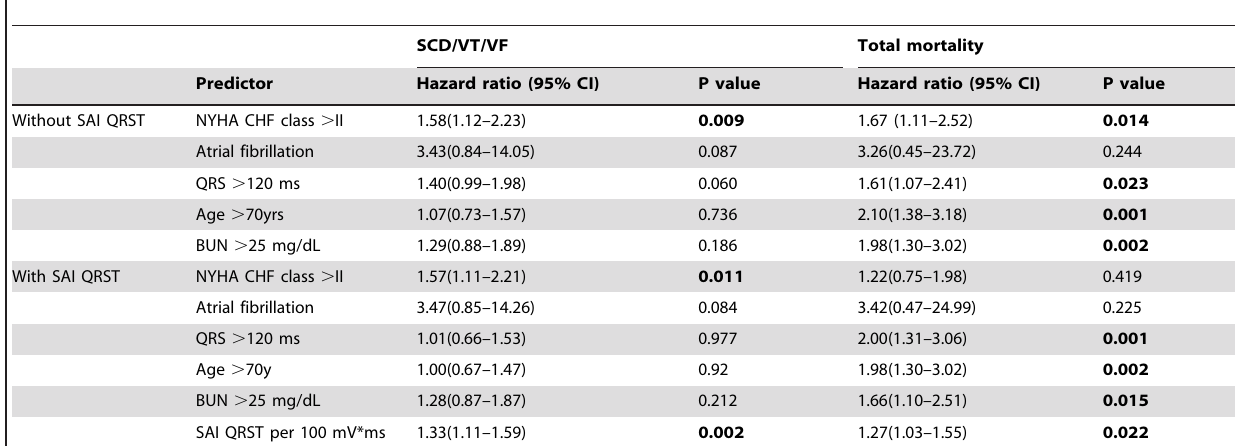
Table 3. Hazard ratios for MADIT II risk score components for sudden arrhythmic death and all-cause